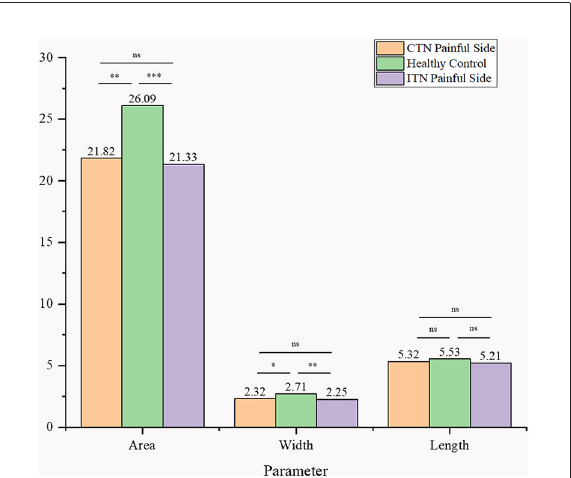
FIGURE5 Morphometric differences in area, width, and length between the three groups were presented. ns, no significance difference;